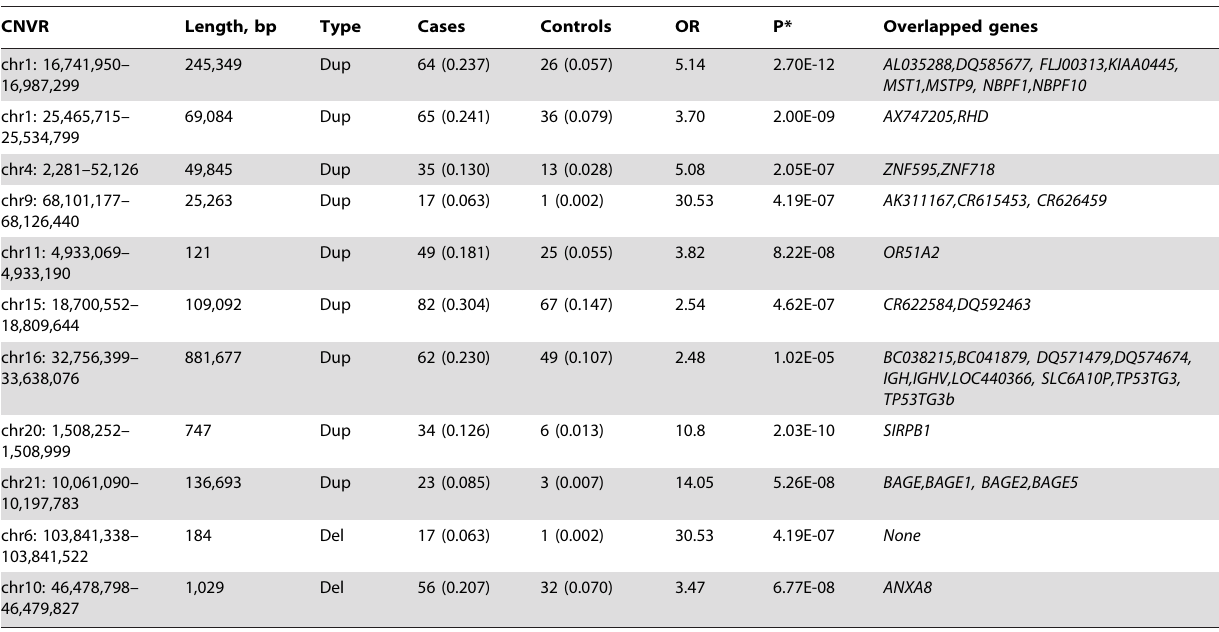
CNVR Length, bp Type Cases Controls OR P* Overlapped genes